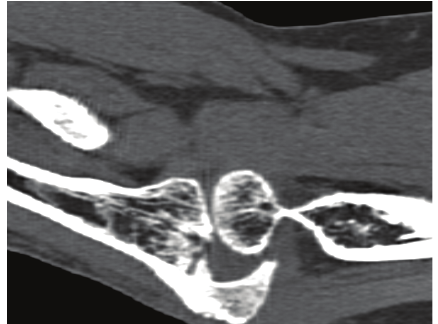
Figure 2: Computed tomographic evaluation revealed depression of the articular surface of the trochlear notch and shortening of the proximal ulna. She had an incongruent ulnohumeral joint leading to impingement and loss of function. The articular surfaces of the radio-capitellar joint remained opposed.